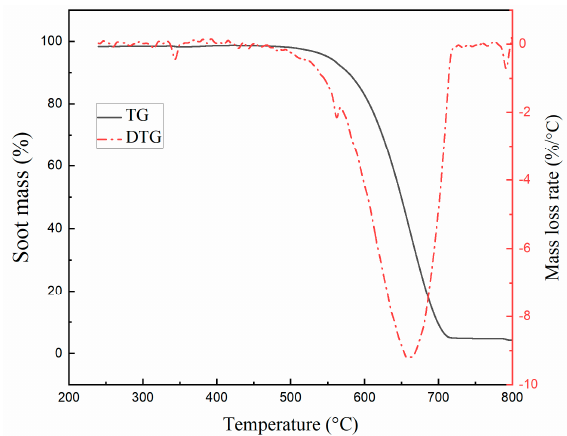
onto the surface of the particles, making oxidation di ffi cult.